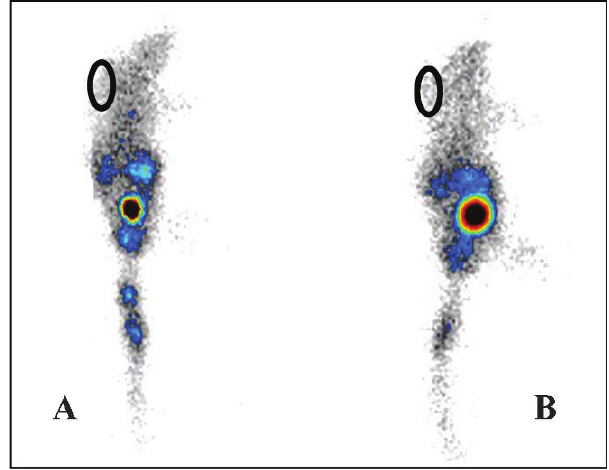
Figure 10 – Scintigraphic images - (A) B-MORF-B- b Ala-BBN + 99m Tc-cMORF (A)(ROI= 3.9%); (B) B-MORF-B-PEG-BBN + 99m Tc- cMORF (ROI=